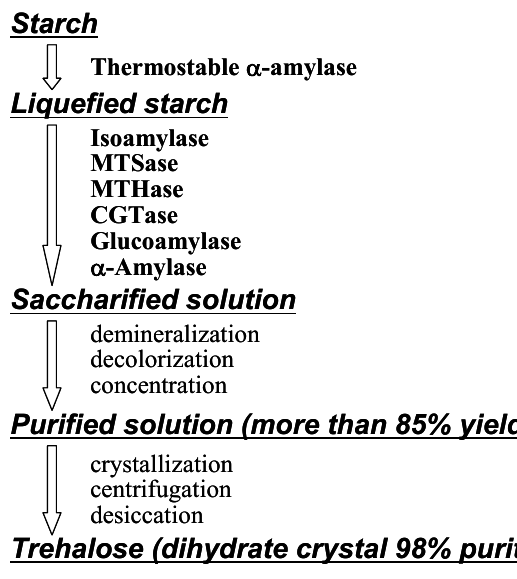
Figure 7. Industrial enzymatic production of α,α -trehalose (reproduced courtesy of IUPAC and Hayashibara Biochemical Laboratories